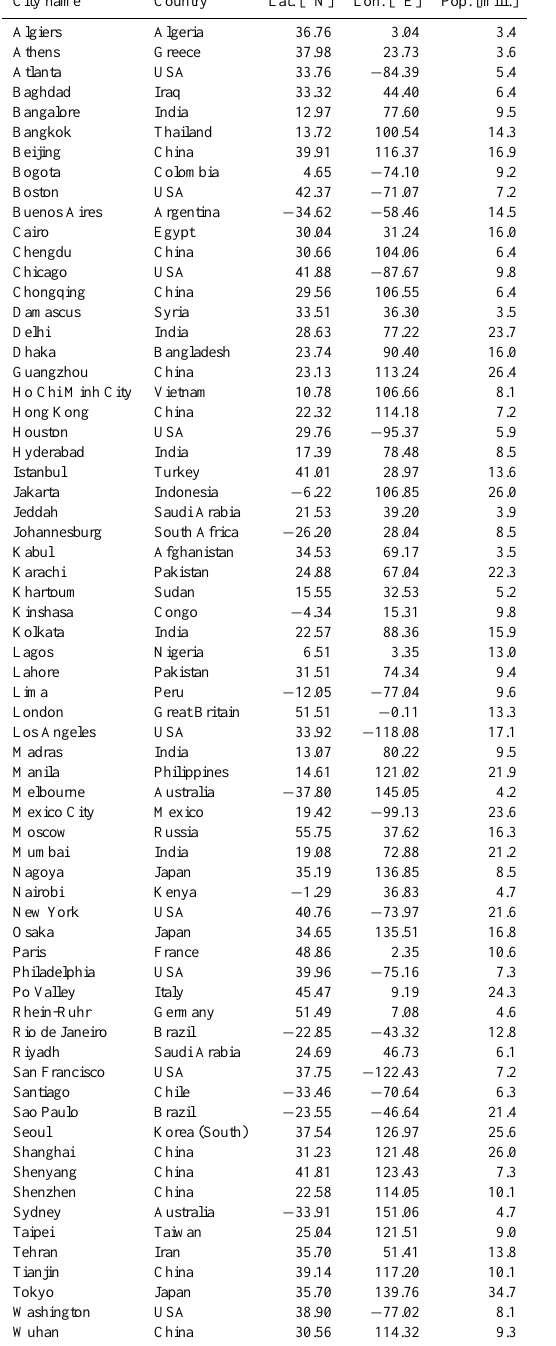
Table 1. Metadata of the selected megacities and other large ur- ban agglomerations. A total of 66 sites were selected based on the criteria listed in Sect. 3.2. The given latitude and longitude values indicate the location at which the time series was extracted from the SCIAMACHY data set. The data on estimated population was taken from United Nations